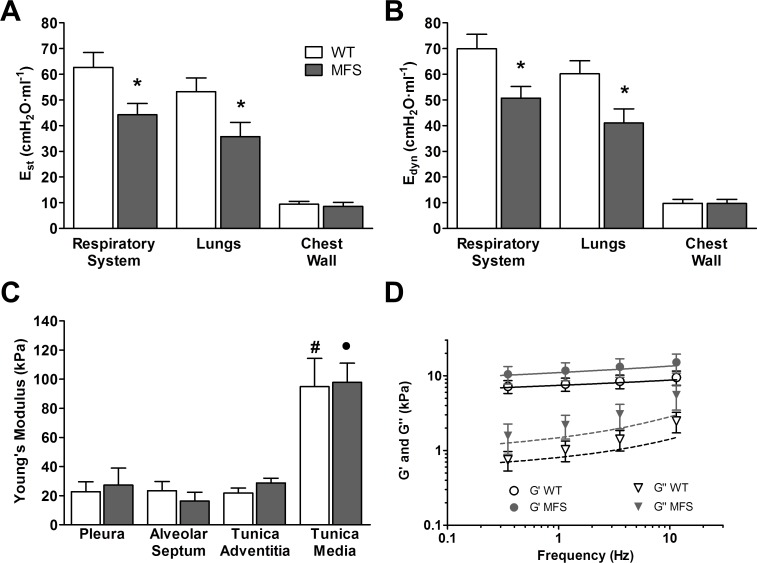
Mechanics in 5-week old mice.(A) Static (Est) and (B) dynamic (Edyn) elastances in WT (white column) and Marfan mice (grey column) determined by the end-inspiratory airway occlusion method. (C) Young’s modulus (E) measured at different regions of the lung ECM in WT (white column) and Marfan mice (grey column). (D) Complex shear modulus (G*) measured at the alveolar septum of decellularized lung matrix in WT (open symbols) and MFS (closed symbols) mice. Circles represent the real part (storage modulus, G’) and triangles represent the imaginary part (loss modulus, G”) of G*. Solid and dashed lines represent fits of the two power law model to G’ and G”, respectively (WT black and MFS grey). Data are mean ± SE. *: p < 0.05.